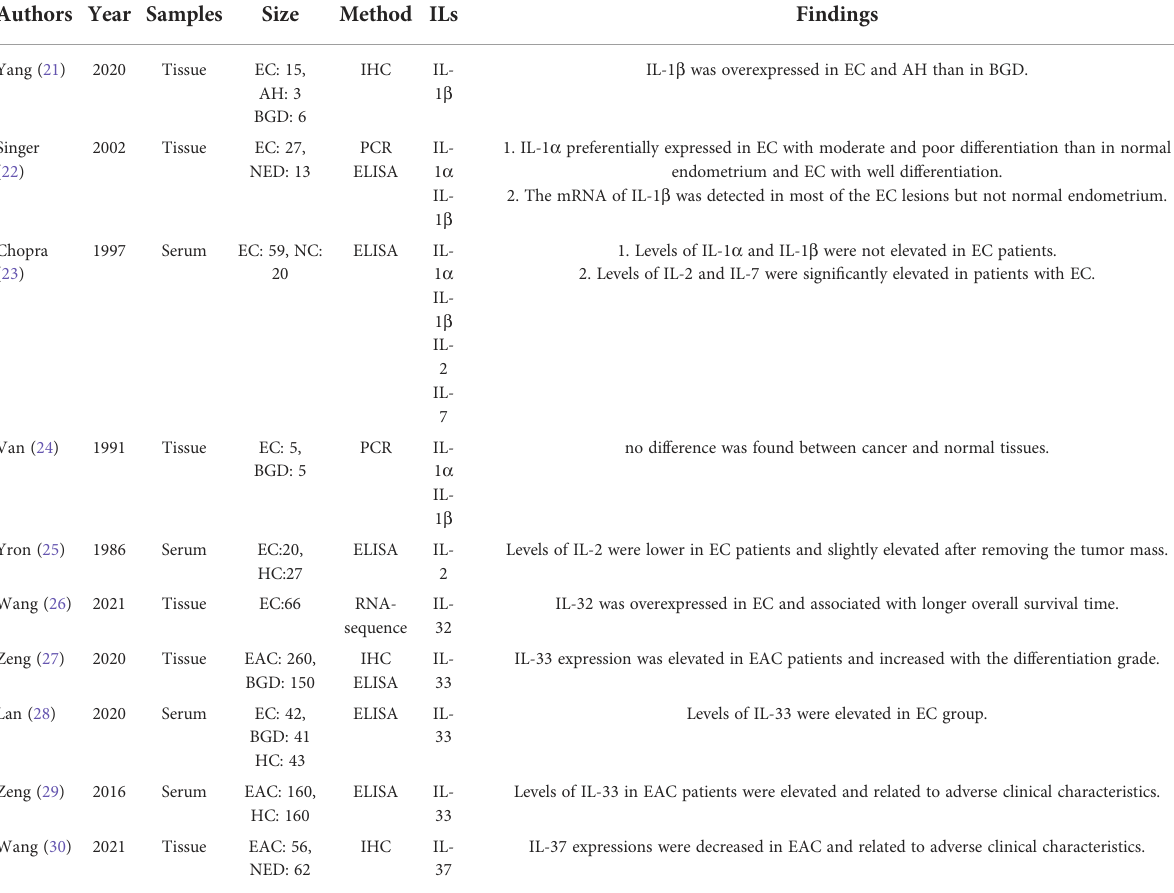
TABLE 1 The expression of IL-1 family and IL-2 family in EC. Authors Year Samples Size Method ILs